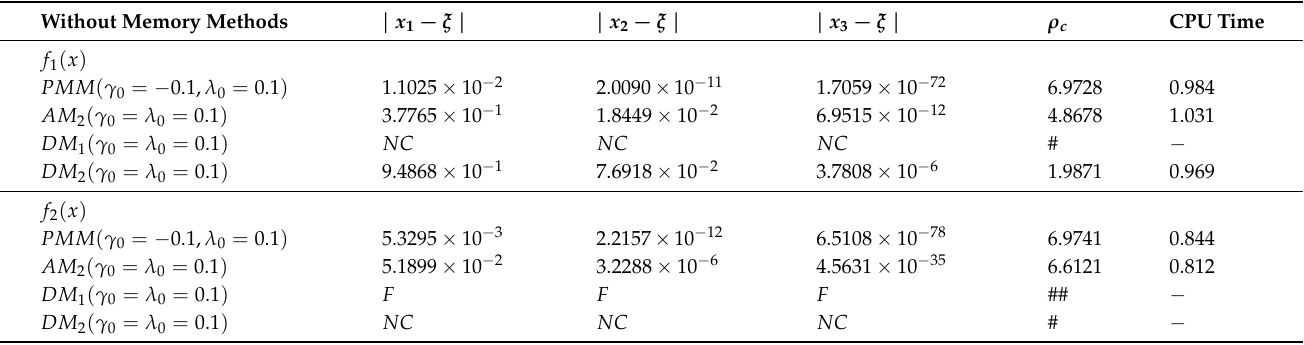
Table 3. Comparison of the different methods with